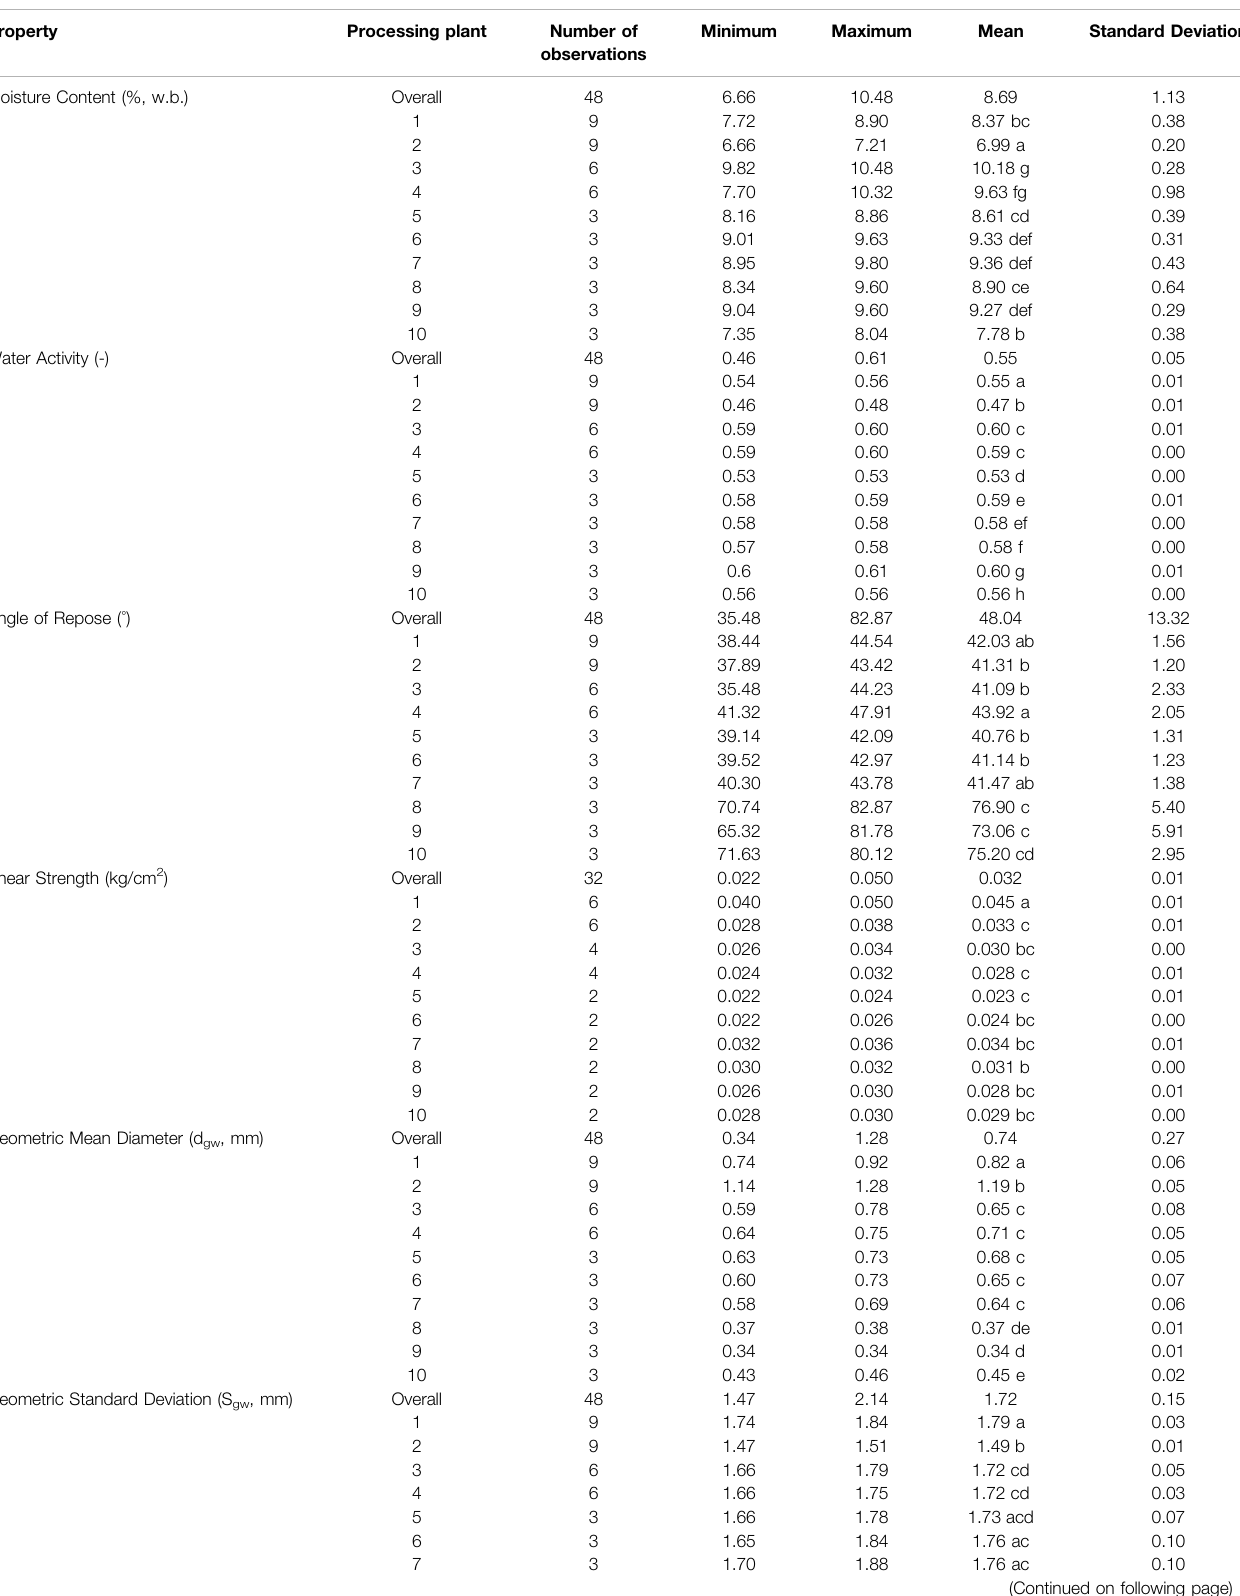
TABLE 1 | Physical and fl ow properties of distillers dried grains with solubles (DDGS). a